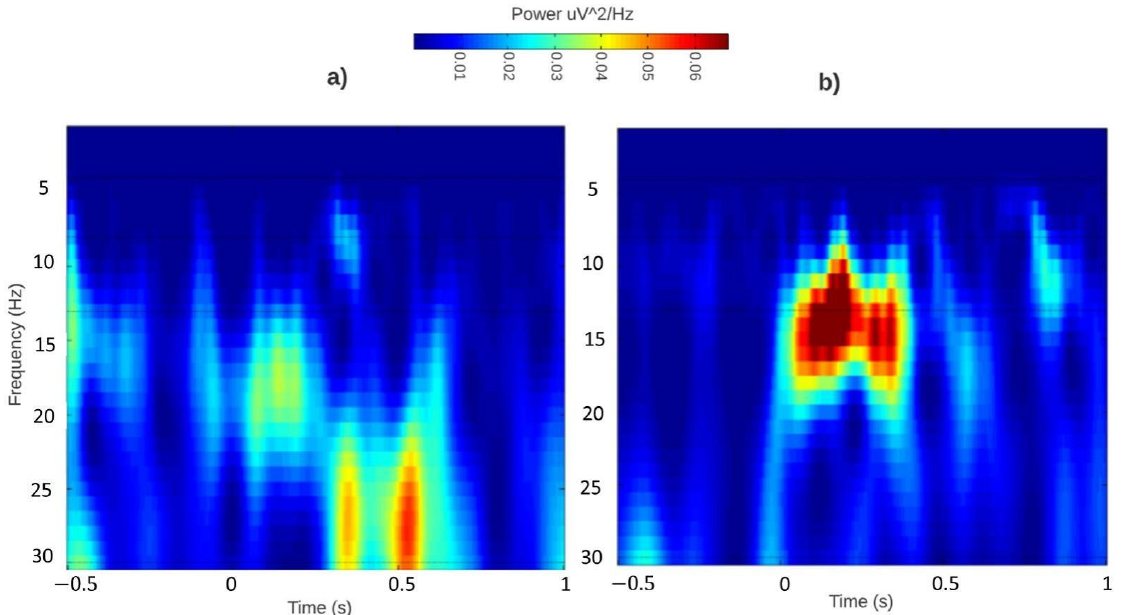
Figure 5. Tinnitus group. ERD/ERS responses over Fz before ( a ) and after ( b ) ADT-based treatment during the auditory recognition event. Fz was selected to illustrated central tendencies since it is the clinical recording site to diagnose tinnitus.